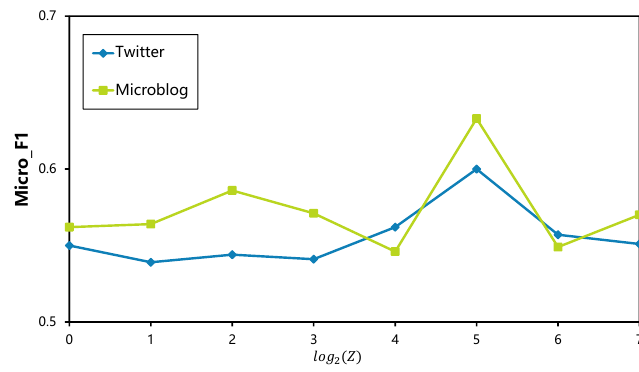
Figure 11. Model parameter analysis (cell size D ).